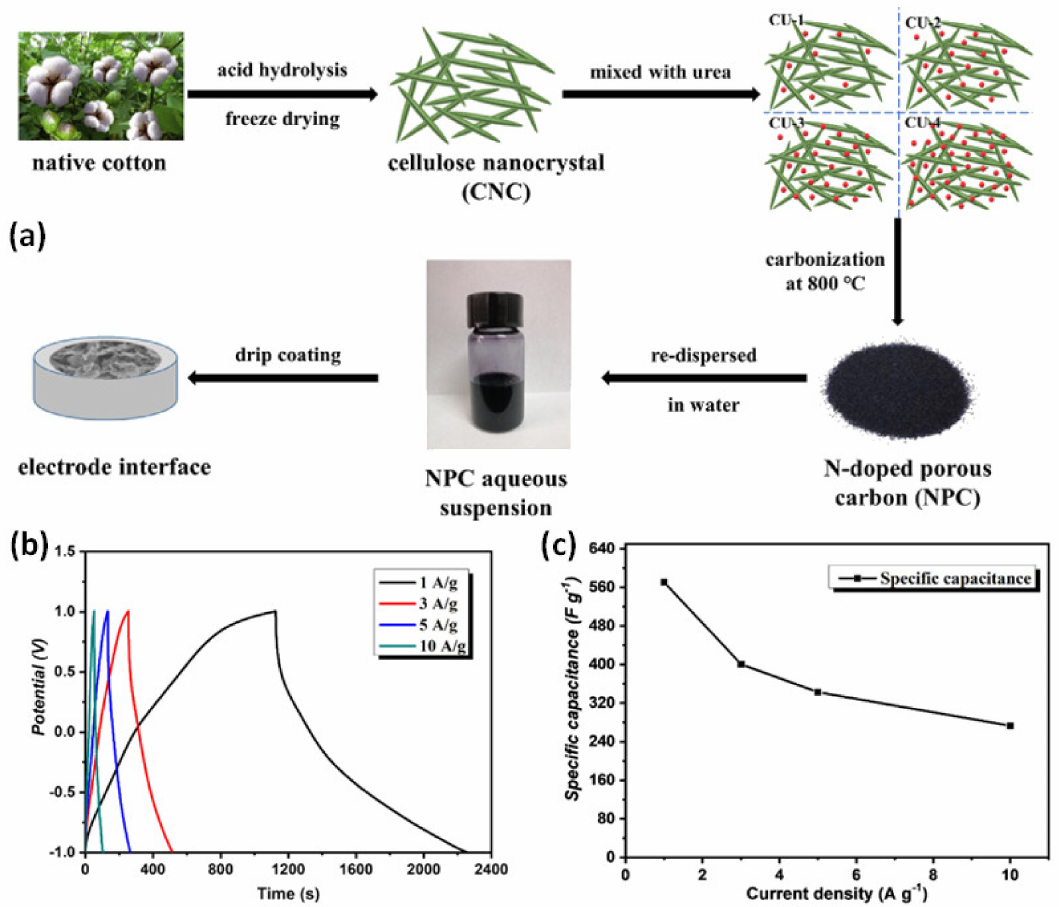
Figure 12. ( a ) N − doped cellulose nanocrystals (N − CNCs) are prepared from cotton and urea. ( b , c ) Electrochemical GCD curve and specific capacitance of N − CNCs under different current densi- ties. Adapted with permission from [122]. Copyright 2020